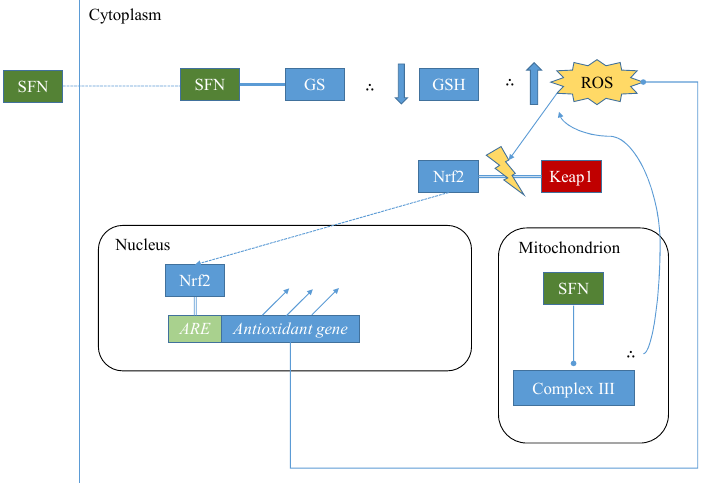
Figure 2. An illustration of the mechanisms by which sulforaphane (SFN) can induce Nrf2. SFN depletes intracellular GSH by forming complexes with it, and also inhibits complex III of the mitochondrial respiratory chain, thus increasing ROS levels. This acute increase in ROS causes Nrf2 to dissociate from Keap1, thereby enabling it to enter the nucleus where it transcriptionally activates antioxidant genes via ARE binding.